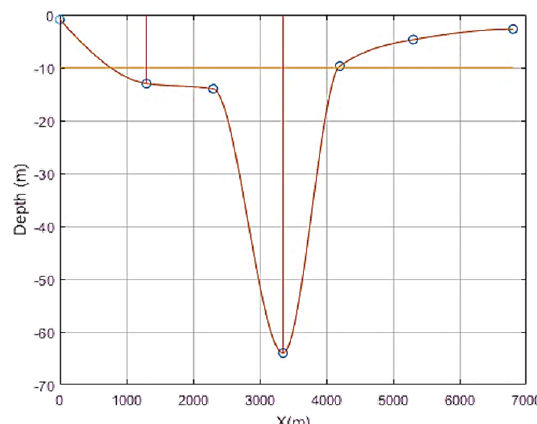
Fig. 9 Assumed velocity contour (m/s) with depth (m) over the entre cross section at San José Gulf.